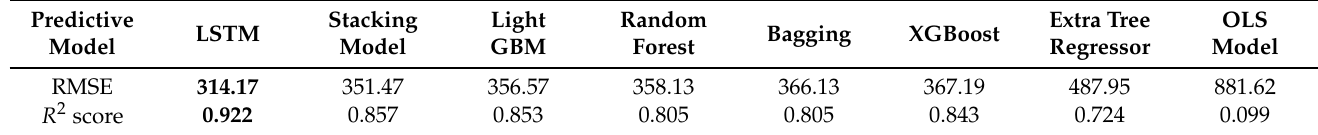
Table 5. Comparison of prediction results of different forecasting